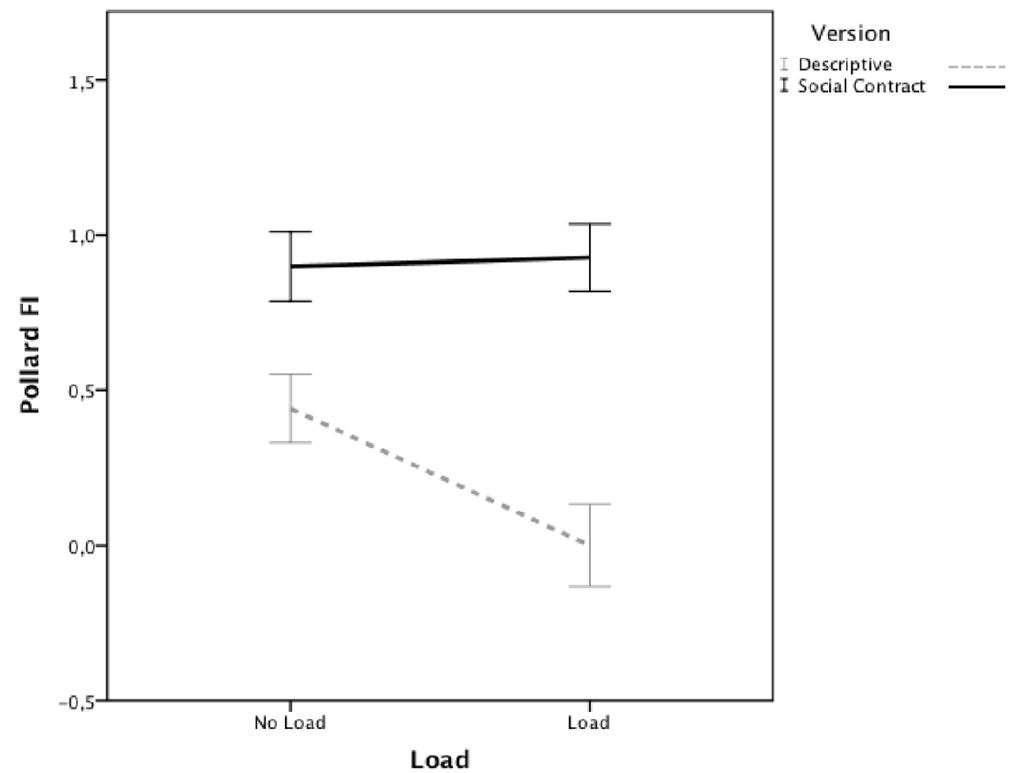
Figure 4. Mean falsification indices for the descriptive and social contract version in the load and no load group. Error bars denote + / 2 1 standard error of the